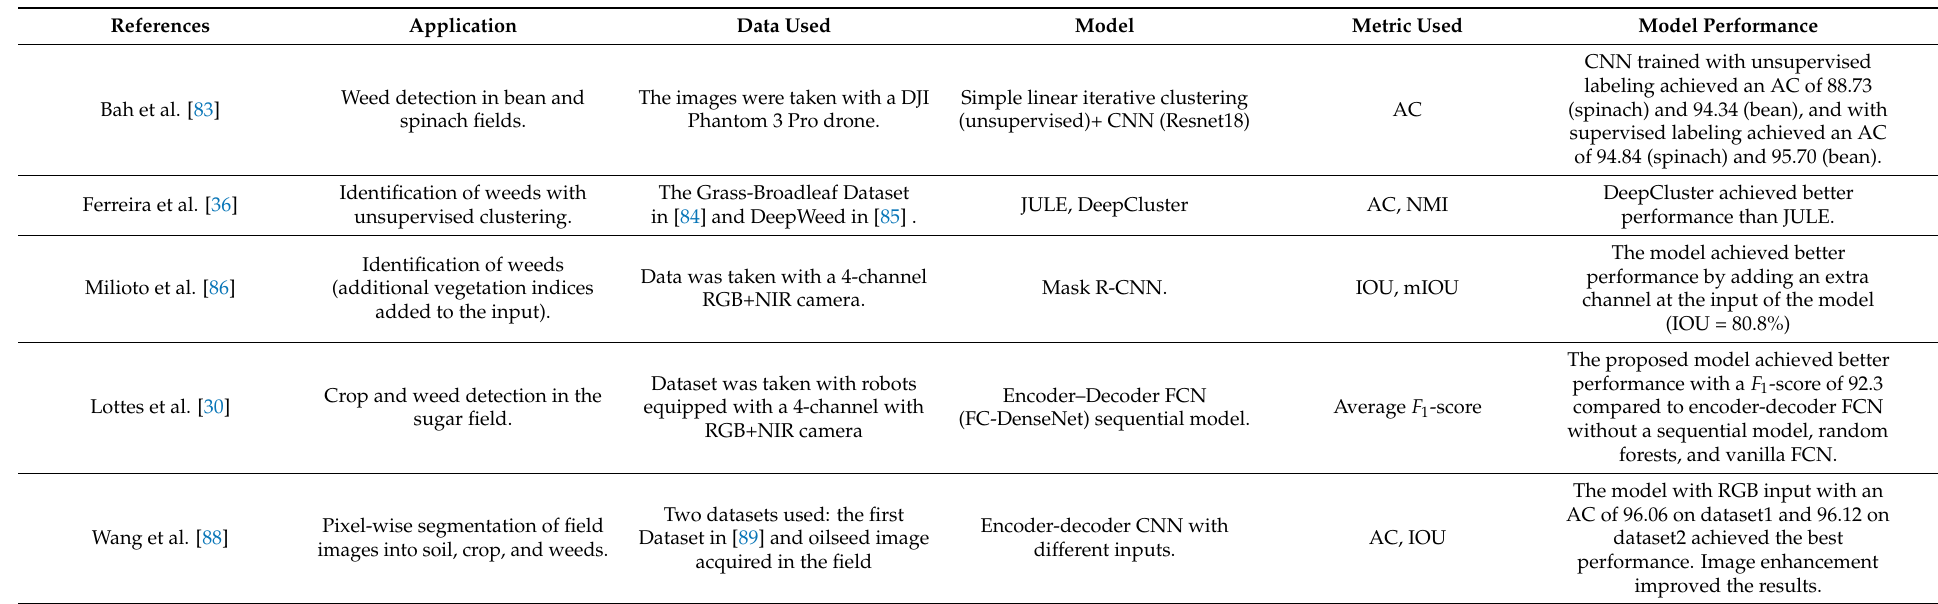
Table 5. Feature descriptions of recent published papers in the field of “Weed